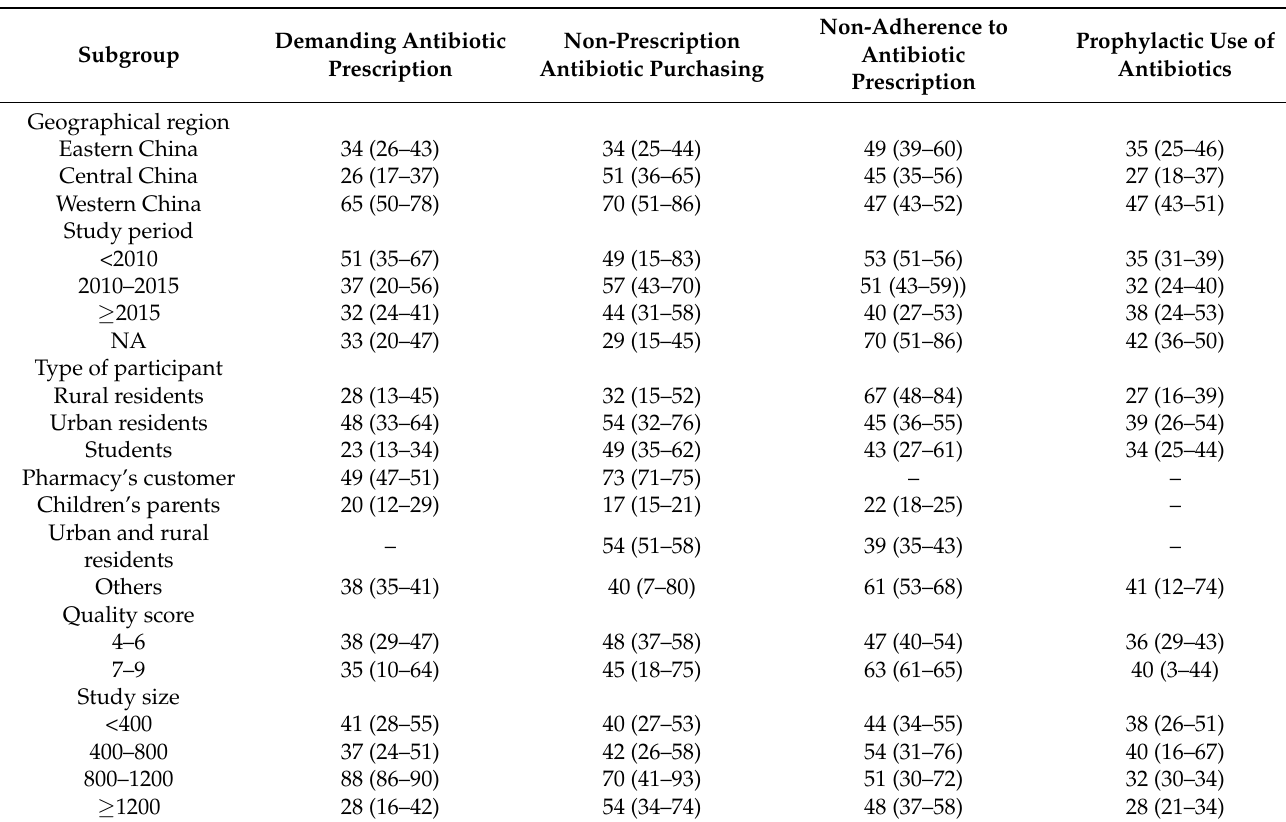
Table 3. Subgroup analysis of the proportion of the general population’s irrational use behaviors regarding antibiotics (%, 95%